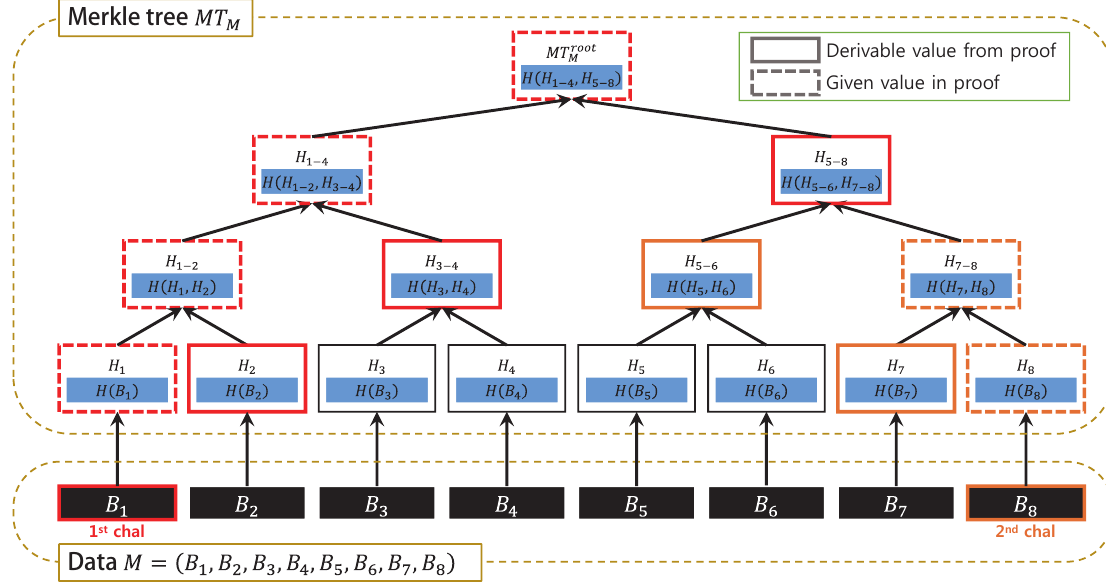
Figure 3. Merkle tree-based authentication for data M with eight